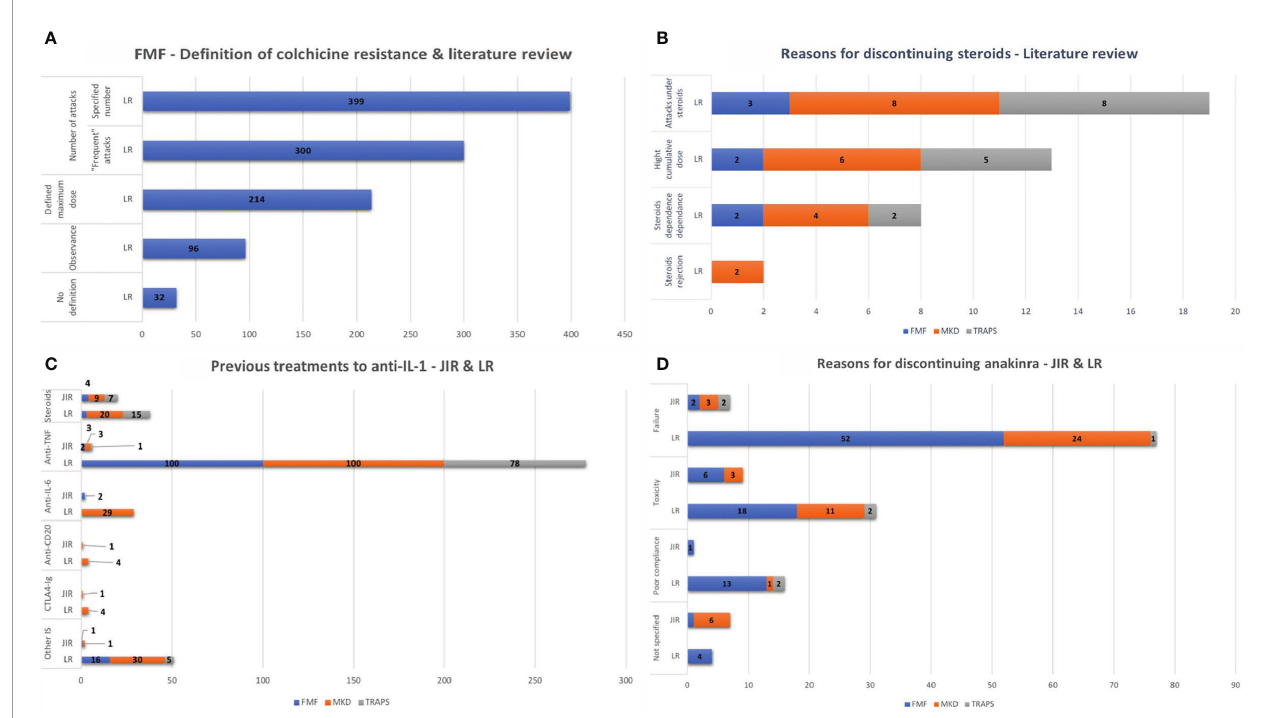
FIGURE 1 | (A) FMF – De fi nition of colchicine resistance and literature review. (B) Previous treatments to IL-1 inhibitors. (C) Reasons for discontinuing steroids – Literature review. (D) Reasons for discontinuing anakinra. IL, interleukin; FMF, familial Mediterranean fever; MKD, mevalonate kinase de fi ciency; TRAPS, tumor necrosis factor receptor-associated periodic syndrome; LR, literature